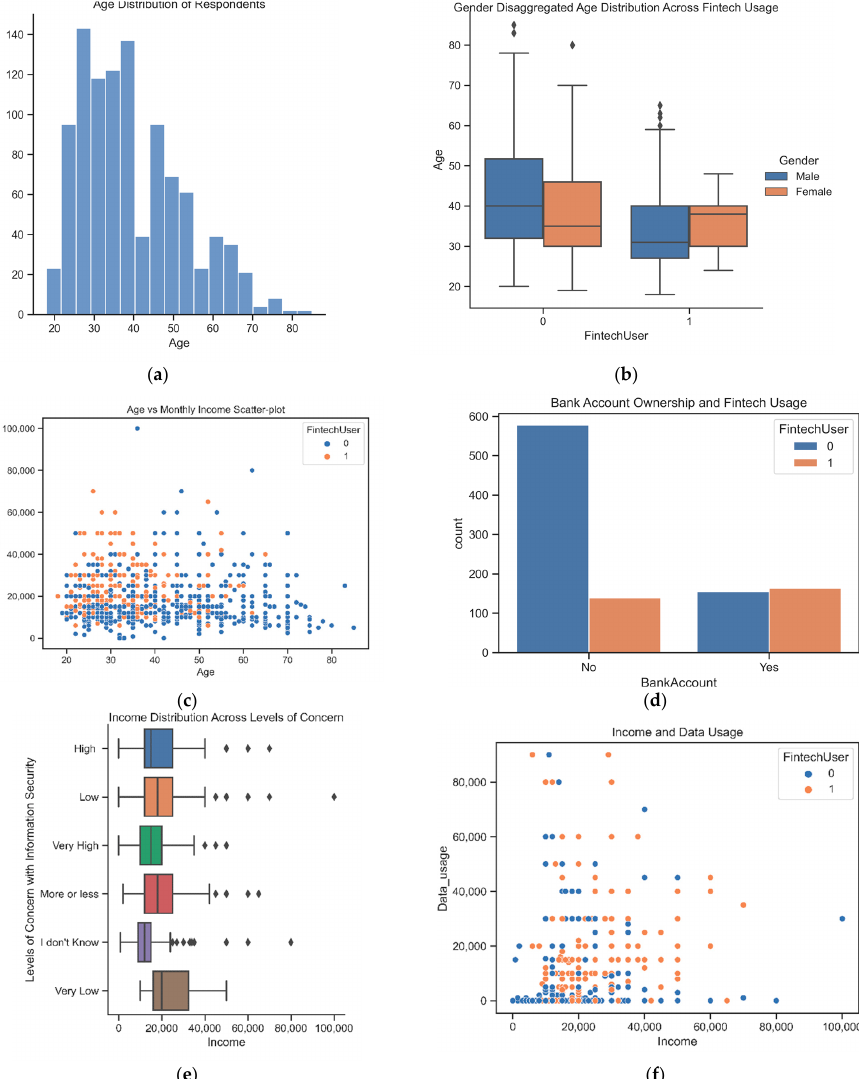
Figure 4. ( a ) Distribution of respondent ages; ( b ) Gender-disaggregated box-plot of age across fintech use; ( c ) Scatter-plot of age and monthly income (fintech use more prevalent in younger and high-income areas; ( d ) fintech use and bank account ownership; ( e ) Distribution of monthly income across different levels of concern for information security; ( f ) Scatter-plot of monthly income and data usage.